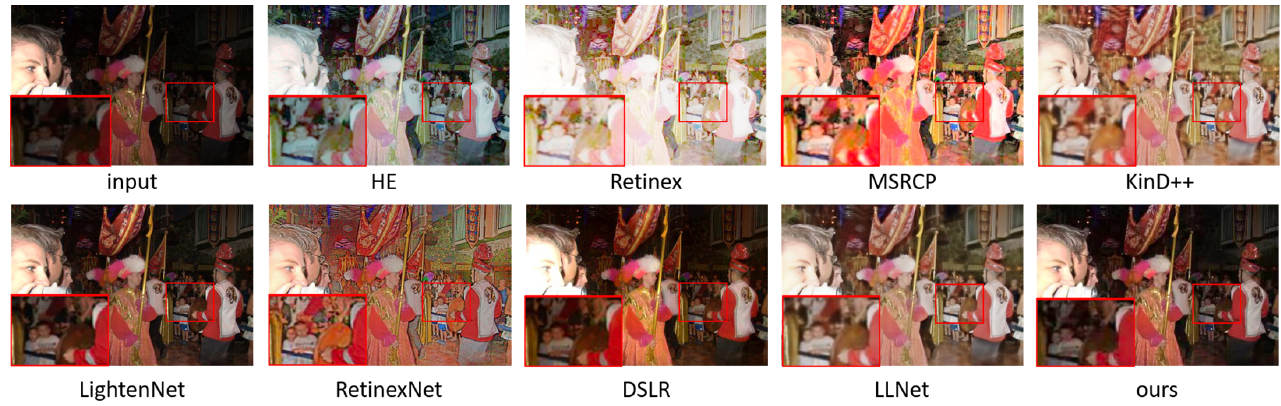
Figure 5. Visual comparison of enhanced renderings of low-illumination images.